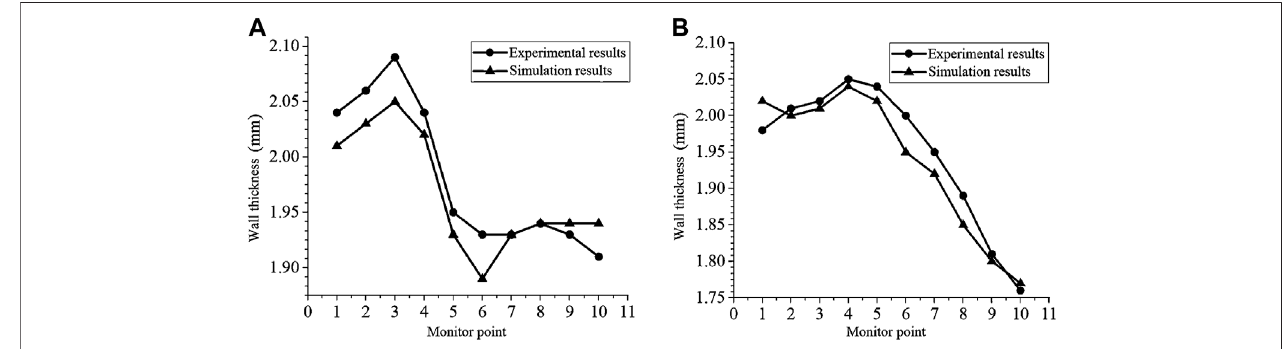
FIGURE 11 | (A) Comparison curve of wall thickness on the contraction section. (B) Comparison curve of wall thickness on the expanding